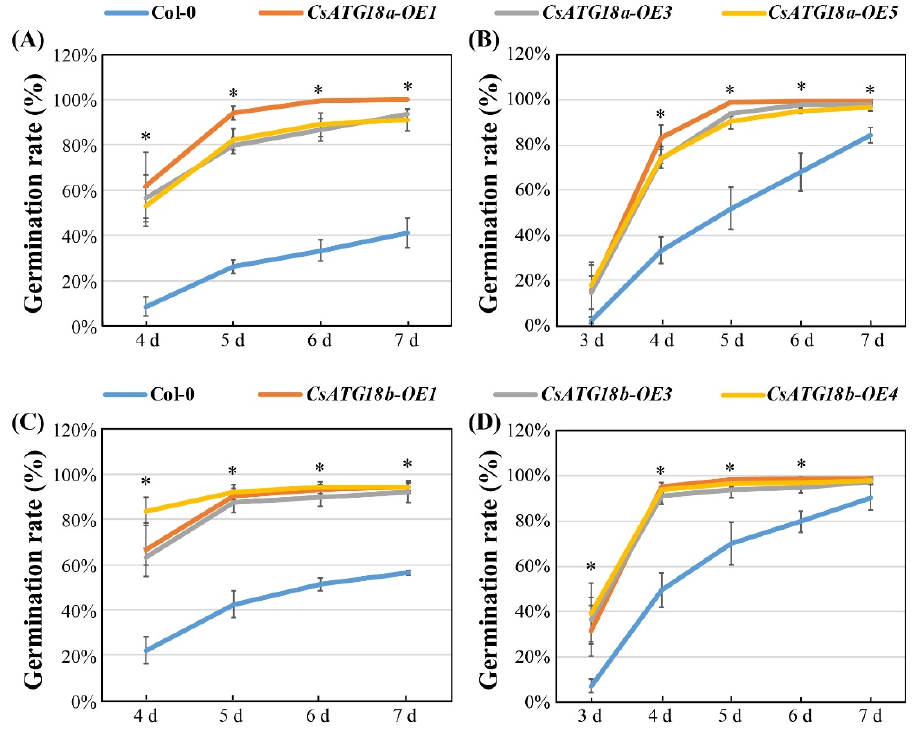
Figure 7. Germination rate of CsATG18a - and CsATG18b -overexpressed (OE) lines and WT under NaCl and mannitol stresses. ( A–D ) Germination rate (%) of three OE lines of CsATG18a and CsATG18b and WT (Col-0) calculated after 4, 5, 6, and 7 days of 200 mM NaCl ( A,C ) treatment and 3, 4, 5, 6, and 7 days of 400 mM mannitol ( B,D ) treatment. The data are the means ± SE of three independent repeats ( n = 60). * indicates a significant difference at p < 0.05 using the least significant difference (LSD) test.